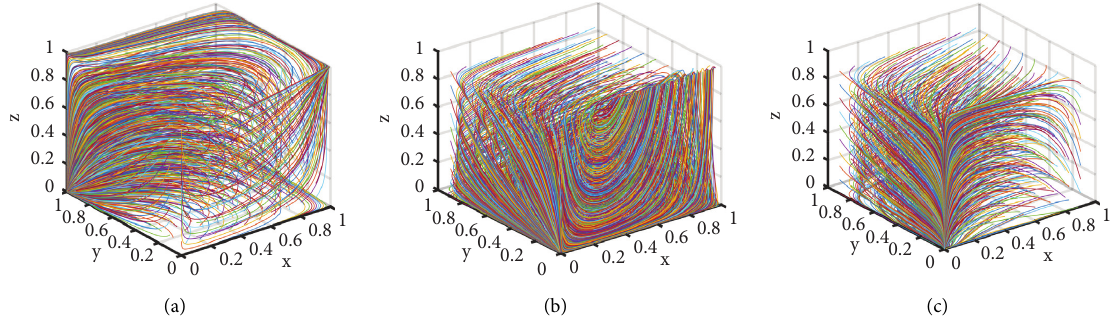
Figure 6: Impact of additional costs on the evolution of each player’s